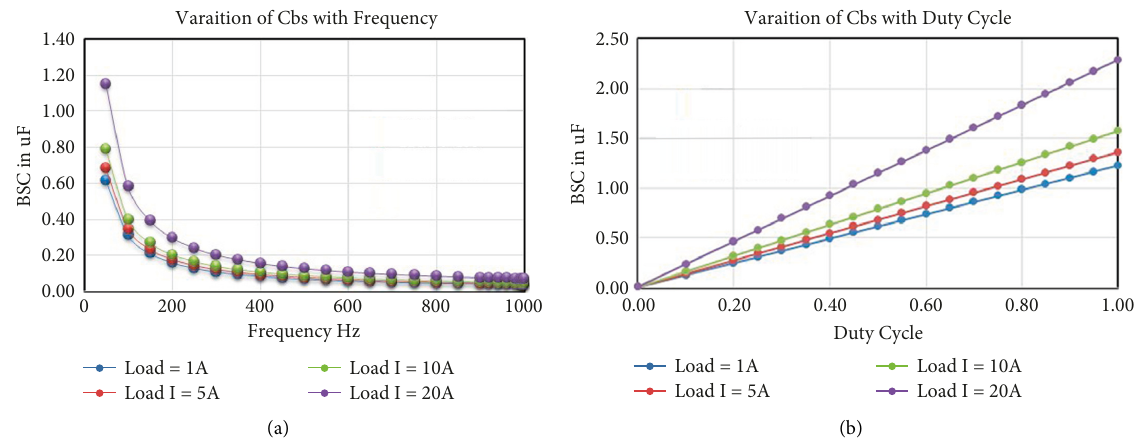
Figure 1: BSC variation with frequency and duty cycle at different loads.